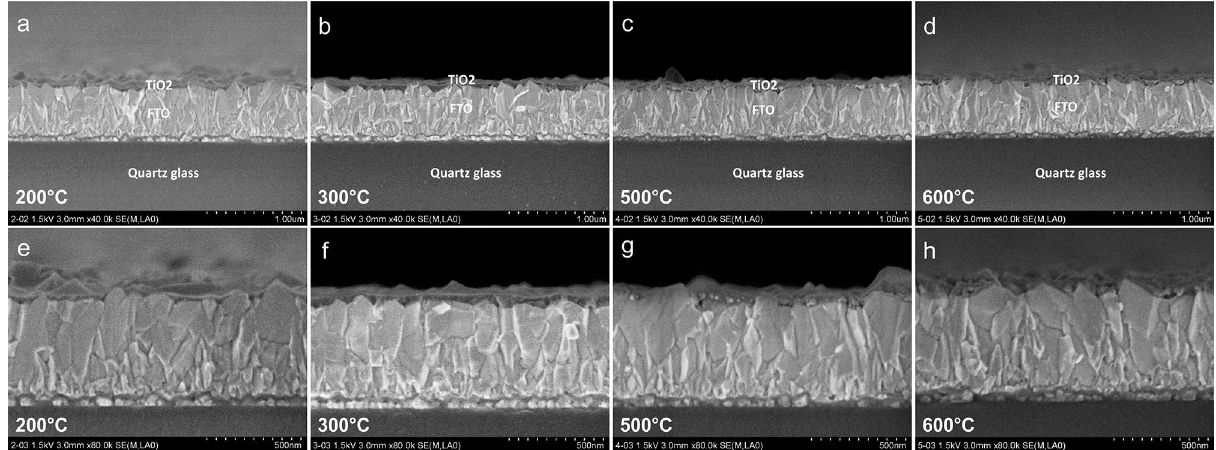
Figure 3. Cross-sectional FESEM images of TiO 2 -coated FTO glass slides calcined at temperatures indicated in the images recorded with 40.0 k magnification ( a – d ) and corresponding images with 80.0 k magnification ( e – h at 27.4 ◦ (major), 35.9 ◦ , and 54.3 ◦ (JCPDF No. 34-0180), and the orthorhombic brookite phase typically shows three reflections with nearly similar intensities at 25.4 ◦ , 25.7 ◦ , and 30.8 ◦ (JCPDF No. 29-1360). Thus, the GIXRD pattern of the TiO 2 nanolayer can be best explained by its assignment to the anatase phase, though only the two most intense peaks corresponding to the (101) and (211) crystal planes can be resolved. In the 600 ◦ C sample two peaks at 24.8 ◦ C and 48.3 ◦ are observed, slightly shifted with respect to the reflections of the 500 ◦ C sample. Again, this diffractogram can be explained best by assigning it to the anatase structure. However, the shift of the (101) reflex from the expected 25.2 ◦ to 24.8 ◦ suggests a strain of the elementary cell in the c-direction. Klaysri et al. reported on a small shift of XRD signals in nanocrystalline anatase upon high temperature treatment in N 2 atmospheres, which was explained by the incorporation of N atoms into the TiO 2 crystal structure accompanied by a distortion of the TiO 6 octahedron 30 . However, the authors reported on a shift to higher 2 𝜃 angles, whereas we observed a shift to lower angles. Rajender and Giri described a broadening and a slight shift of the (101) reflex of anatase to lower angles in the X-ray diffractogram of ball-milled TiO 2 nanocrystals 31 and assigned this to milling- induced tensile strain in the nanocrystals. This shift was accompanied by the appearance of two additional peaks at 31.3 ◦ and 41.6 ◦ , which were attributed to the (112) and (312) planes of a newly formed oxygen-deficient Ti 3 O 5 phase (JCPDS No. 74-0819). A closer look at the diffractogram of the TiO 2 nanolayer annealed at 600 ◦ C of our